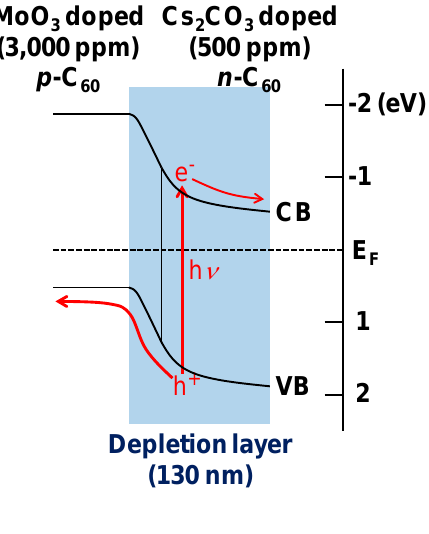
Figure 16. Energetic structure of pn -homojunction formed after contact measured by Kelvin band mapping. The doping concentrations of Cs and 3000 ppm,